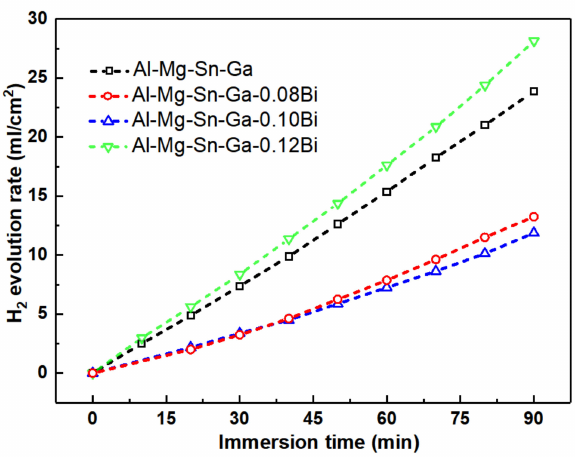
Figure 5. Hydrogen evolution rates of Al-Mg-Sn-Ga-xBi